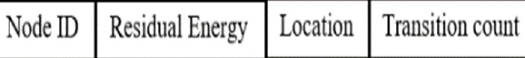
Fig. 4. Hi Message